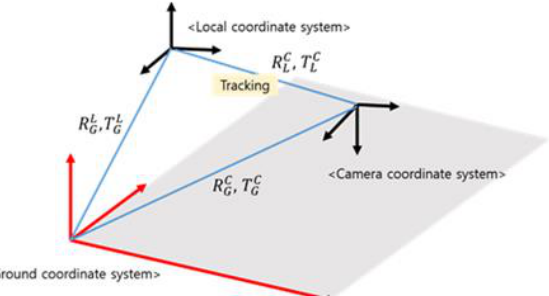
Figure 3. Relationship between coordinate